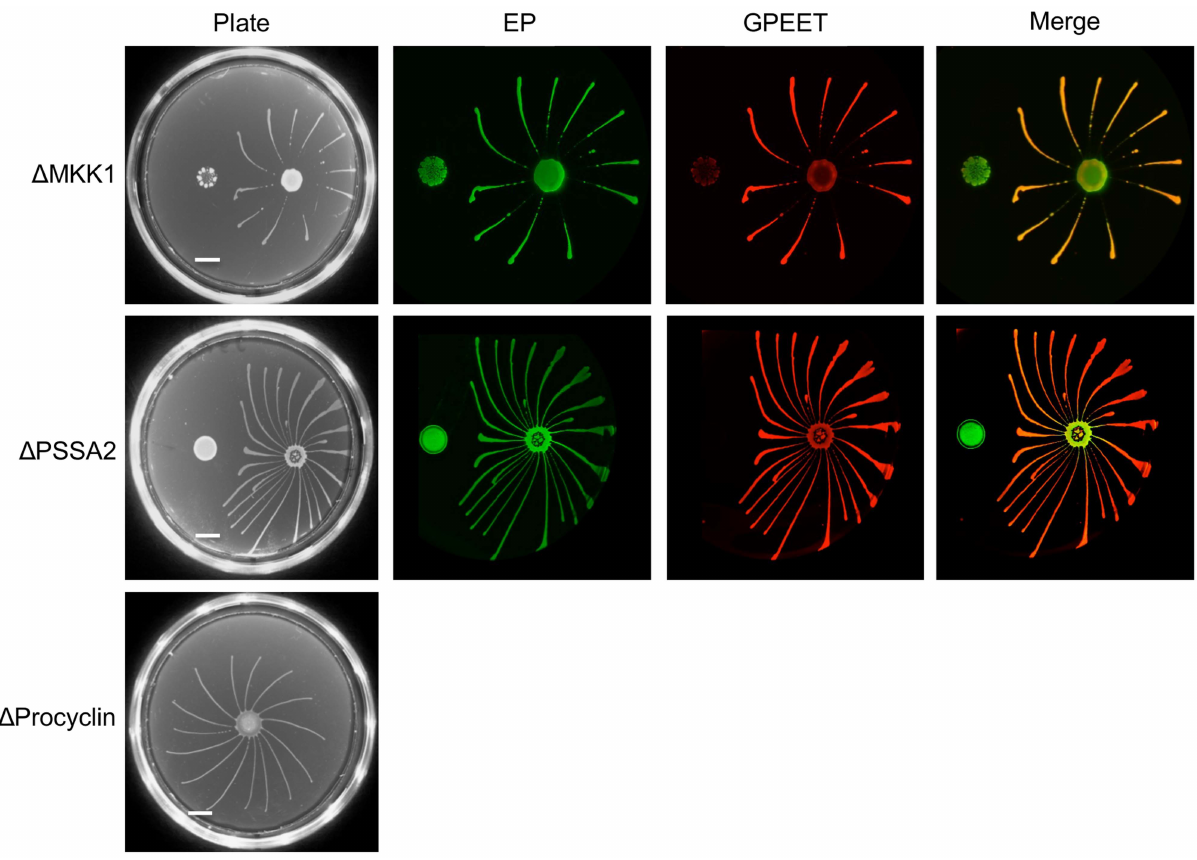
Figure 8. Deletion mutants with defects in salivary gland infection rates are SoMo-positive. A and B. MKK1 and PSSA-2 deletion mutants were cultured with or without glycerol. 4 6 10 5 cells from each culture were inoculated onto plates containing 20 mM glycerol. The scale bar is 1 cm. Four days post plating community lifts were incubated with a -EP and a -GPEET antibodies. C. 2 6 10 5 cells of the procyclin null mutant ( D proc), obtained by differentiation of bloodstream forms, were inoculated onto a 0.4% agarose plate containing 20 mM glycerol. A photograph was taken 4 days post plating.